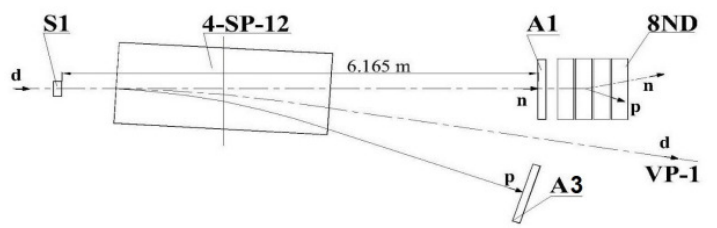
Figure 4. Scheme of the neutron detector